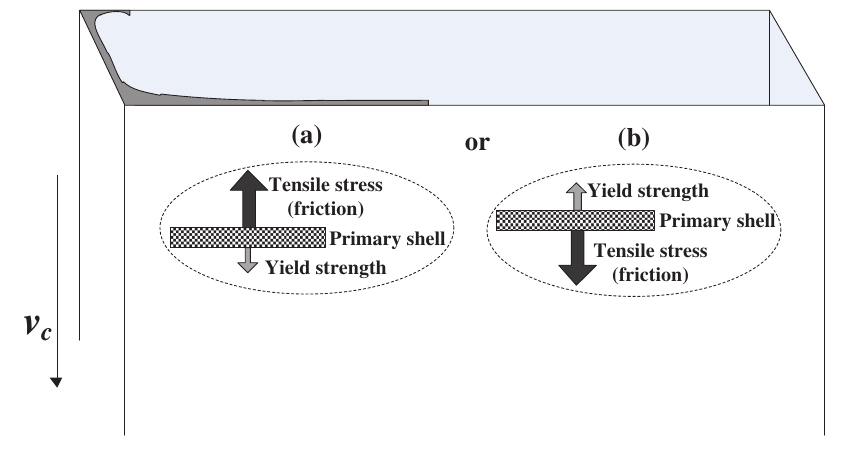
Figure 1: Stress state of primary solidified shell under up/down oscillation of